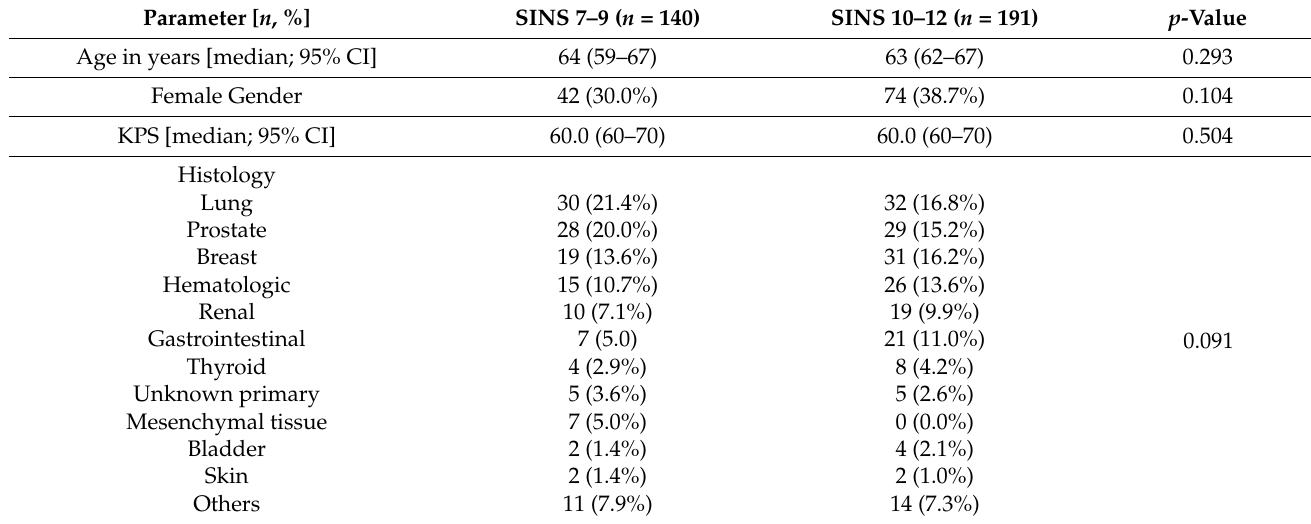
Table A3. Comparison of the subgroups SINS 7 to 9 and SINS 10 to